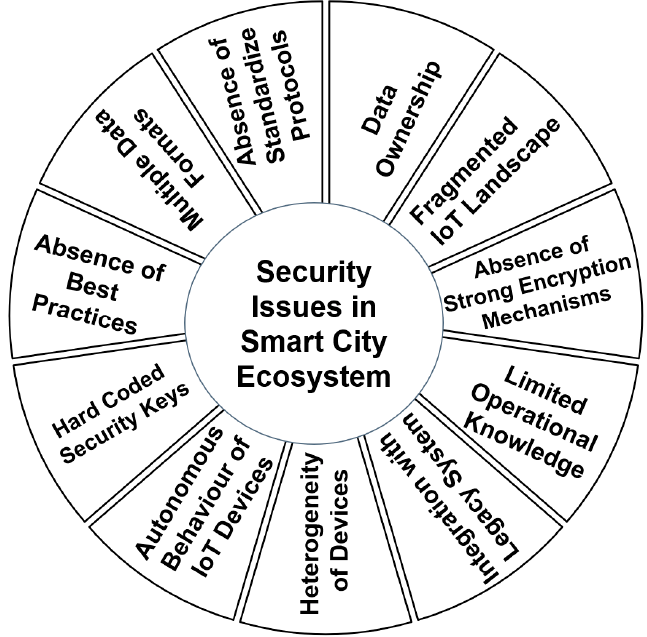
Figure 4. Security issues in smart city